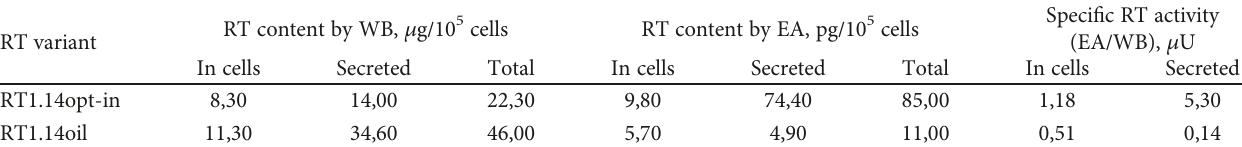
Table 1: Expression, secretion, and residual enzymatic activity of inactivated forms of HIV reverse transcriptase RT1.14opt-in and RT1.14oil in transiently transfected HeLa cells. RT content was determined by Western blotting using protein calibration curves with signal quanti fi cation by ImageJ (dubbed WB, in μ g/10 5 cells) and by quanti fi cation of enzymatic activity against standard RT preparation using Lenti RT activity test (Cavidi, Sweden) (dubbed EA, in pg/10 5 cells). RT content in cell lysates is dubbed “ in cells ” and in cell culture fl uids “ secreted. ” Speci fi c activity was measured as a ratio of protein content evaluated using the enzymatic activity assay to RT content determined by Western